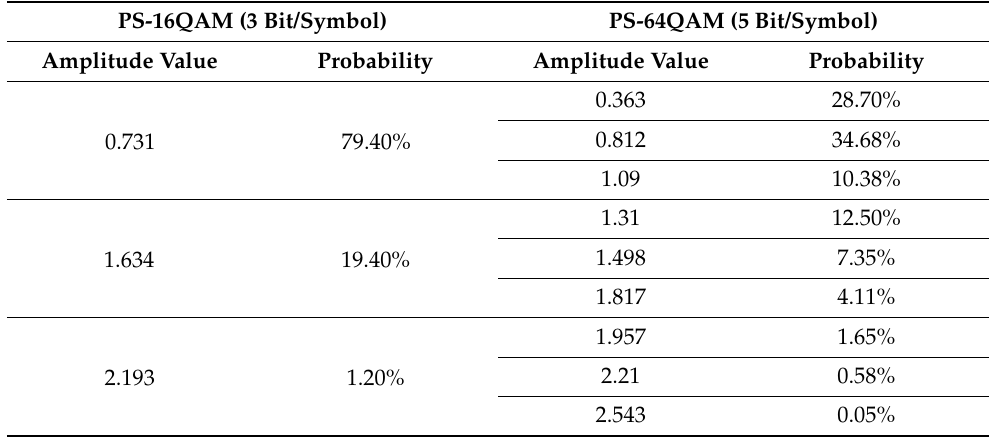
Table 2. Amplitude value and associated probability for each level of PS-16QAM and PS-64QAM